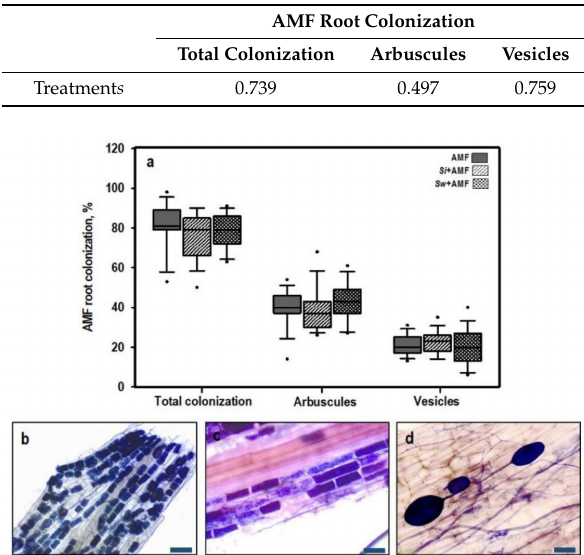
Table 1. Results of the one-way ANOVA ( p -values) for the arbuscular mycorrhizal fungi (AMF) root colonization parameters in tomato plants nine weeks after transplanting ( p < 0.05, n = 15).